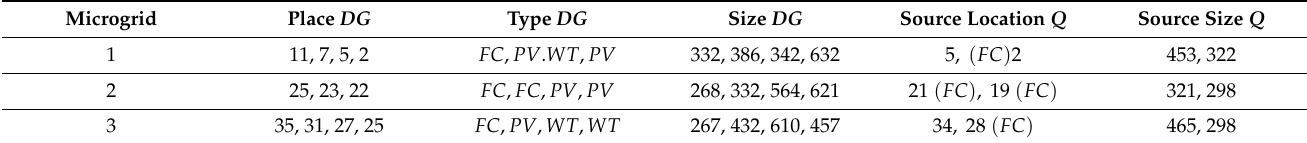
Table 5. Specifications of resources installed in the network in terms of kW and kVAr.